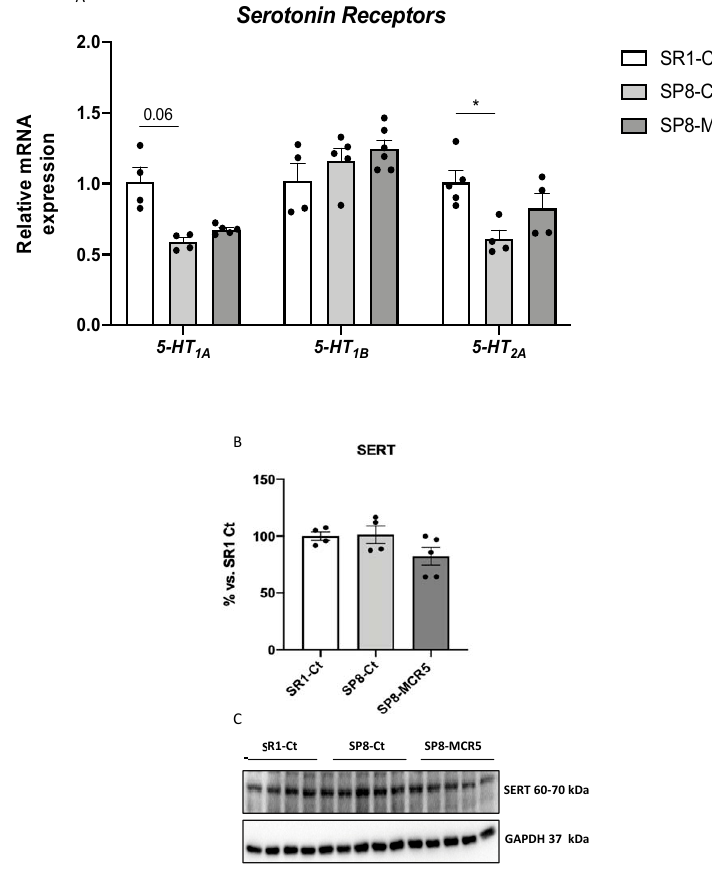
Figure 4. Representative gene expression for 5-HT 1A , 5-HT 1B , and 5-HT 2A ( A ) . Representative Western Blot and quantification for SERT ( B , C ). Gene expression levels were determined by real-time PCR. Values in bar graphs are adjusted to 100% for protein levels of the control SAMR1 (SR1-Ct). Values are the mean ± Standard error of the mean (SEM); ( n = 4–6 for each group). * p <